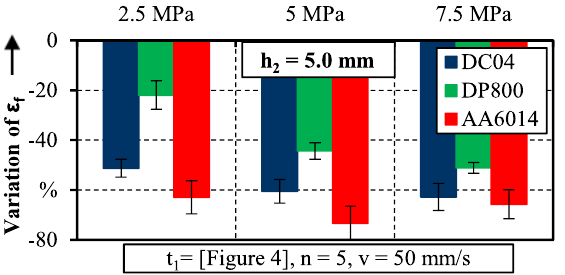
Fig. 13. Modi fi cation of the tensile strength TS in comparison for two drawbead heights and pressure levels.